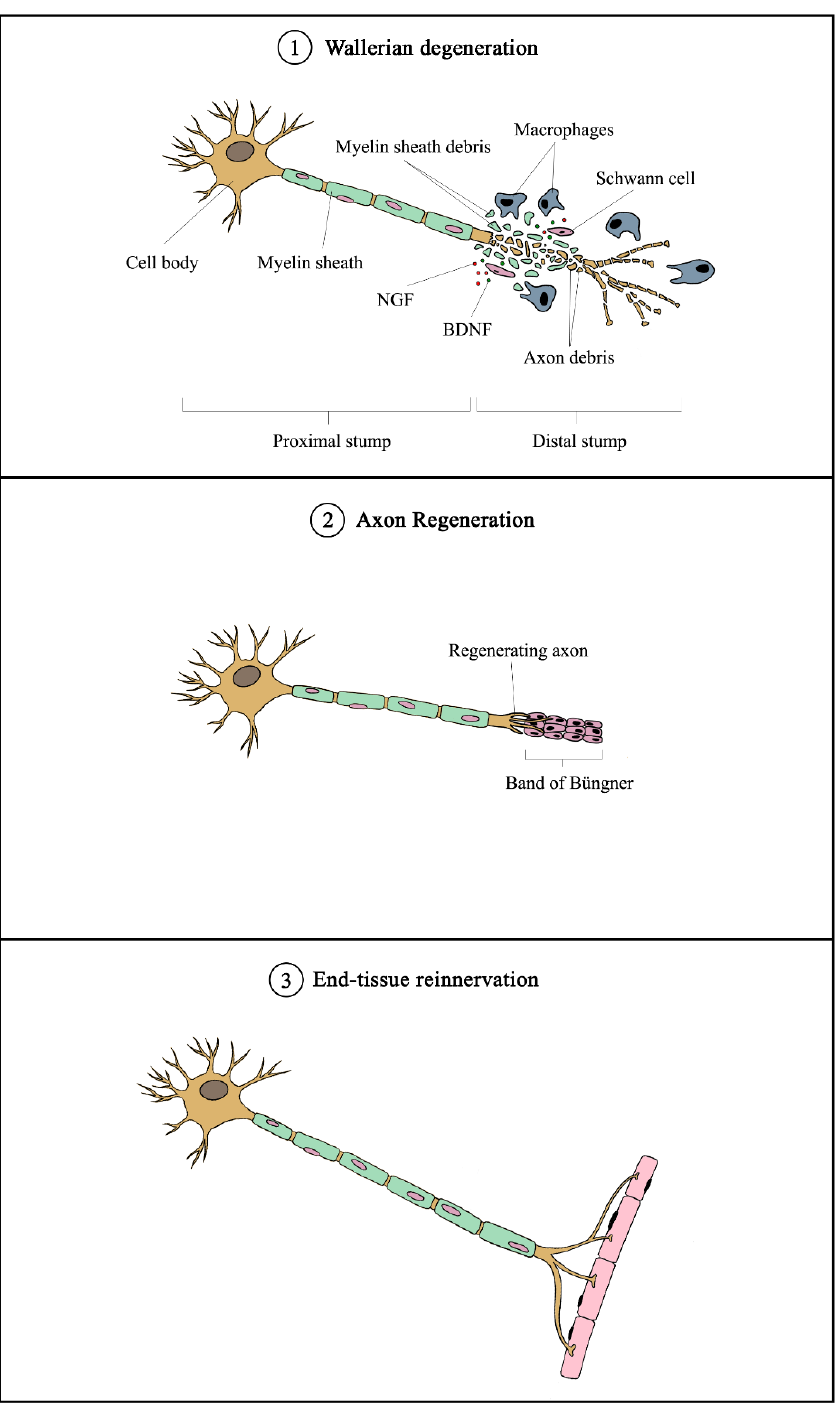
Figure 2. Overview of mechanism of peripheral nerve injury and regeneration. Following nerve injury, Wallerian degeneration occurs, in which axons begin to disintegrate at the distal end, and growth factors (such as NGF and BDNF) are released by Schwann cells. Galectin-3 macrophages are recruited to remove axonal debris and degrade myelin sheaths. Subsequently, SCs align to form the Band of Büngner, which guides the regenerating axons from the proximal to distal sites. Eventually, the regenerated axons innervate the end tissue to complete the recovery process. NGF—nerve growth factor; BDNF—brain-derived neurotrophic factor.